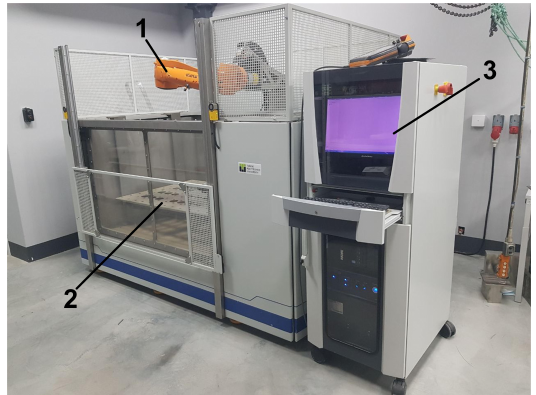
Figure 5. Experimental setup (1—robotic manipulator; 2—immersion bath; 3—control cabinet). The OLYMPUS A307S-SU transducer was used in experiments. The nominal cen- tral frequency of the probe was 5 MHz with the diameter of piezolement is 25.4 mm. The magnitude of the pulse spectrum of the applied transducer is demonstrated in Figure 6. According to pulse spectrum the peak frequency of the transducer was 5.55 MHz and − 6 dB bandwidth was 49.3%.